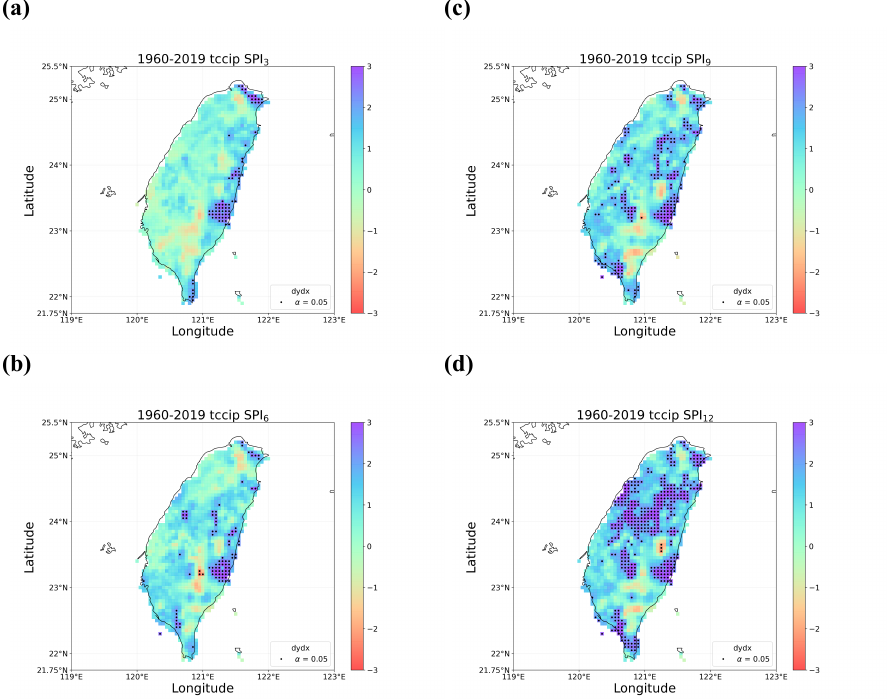
Figure 3. The same as Figure 2, but for detected trends using first derivatives of regularized minimal-energy tensor-product B-splines